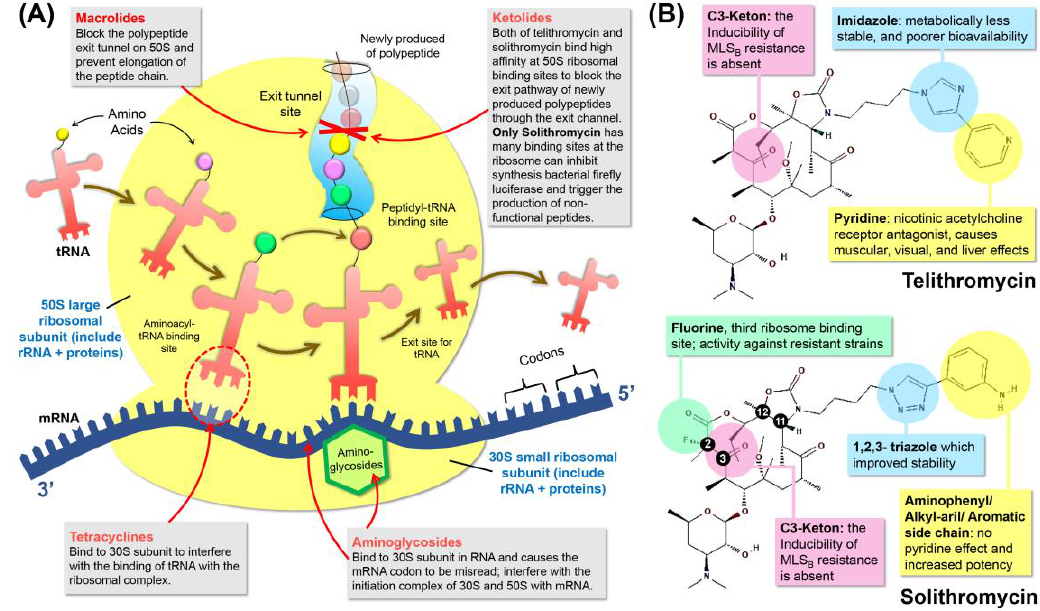
Figure 2. A Summary of the mechanism of action of several antigonococcals and differences in chemical structures between telithromycin and solithromycin (ketolides class). (A) Mechanism of action of ketolides, macrolides, tetracyclines, and aminoglycosides in eradicating GO by inhibiting protein synthesis. (B) Significant chemical structure differences between telithromycin and solithromycin which might combat resistance mechanism of GO (Images modified by the author). (Berg et al., 2002; Carlson-banning & Zechiedrich, 2013; Clarkson, 2018; Donald et al., 2017; Fernandes et al., 2016; Ian & Marilyn, 2001; Lohsen & Stephens, 2019; NCBI, 2020a, 2020b; Ng et al., 2002; Sergeeva et al., 2014; Serio et al., 2017; Tenson et al.,